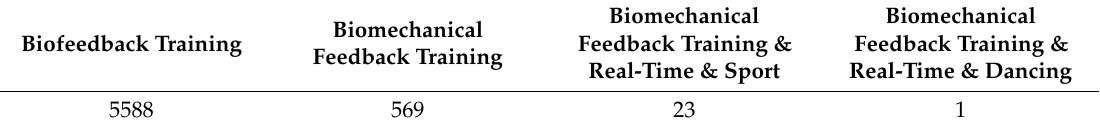
Table 1. The result of literature search in all databases of Web of Science on 11 October